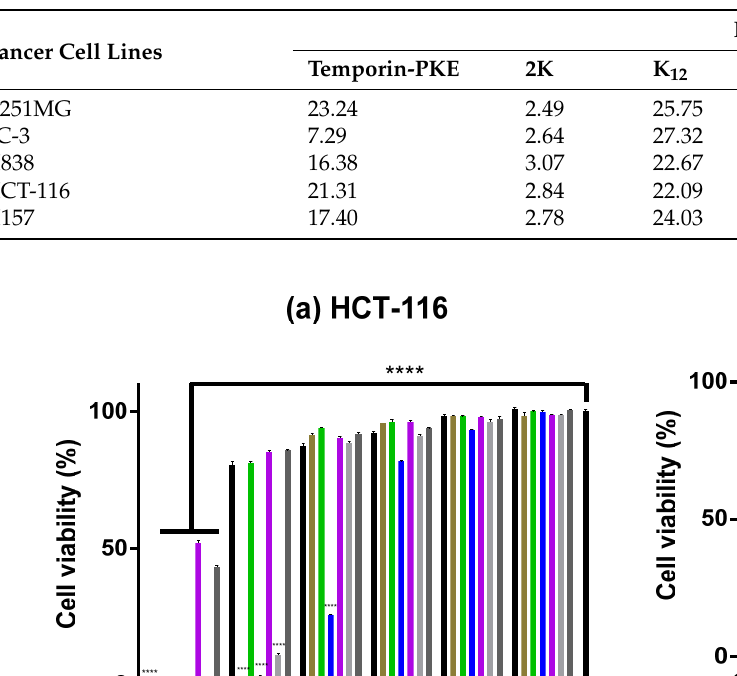
Table 9. The IC 50 values of temporin-PKE and its derivatives against several cancer cell lines.